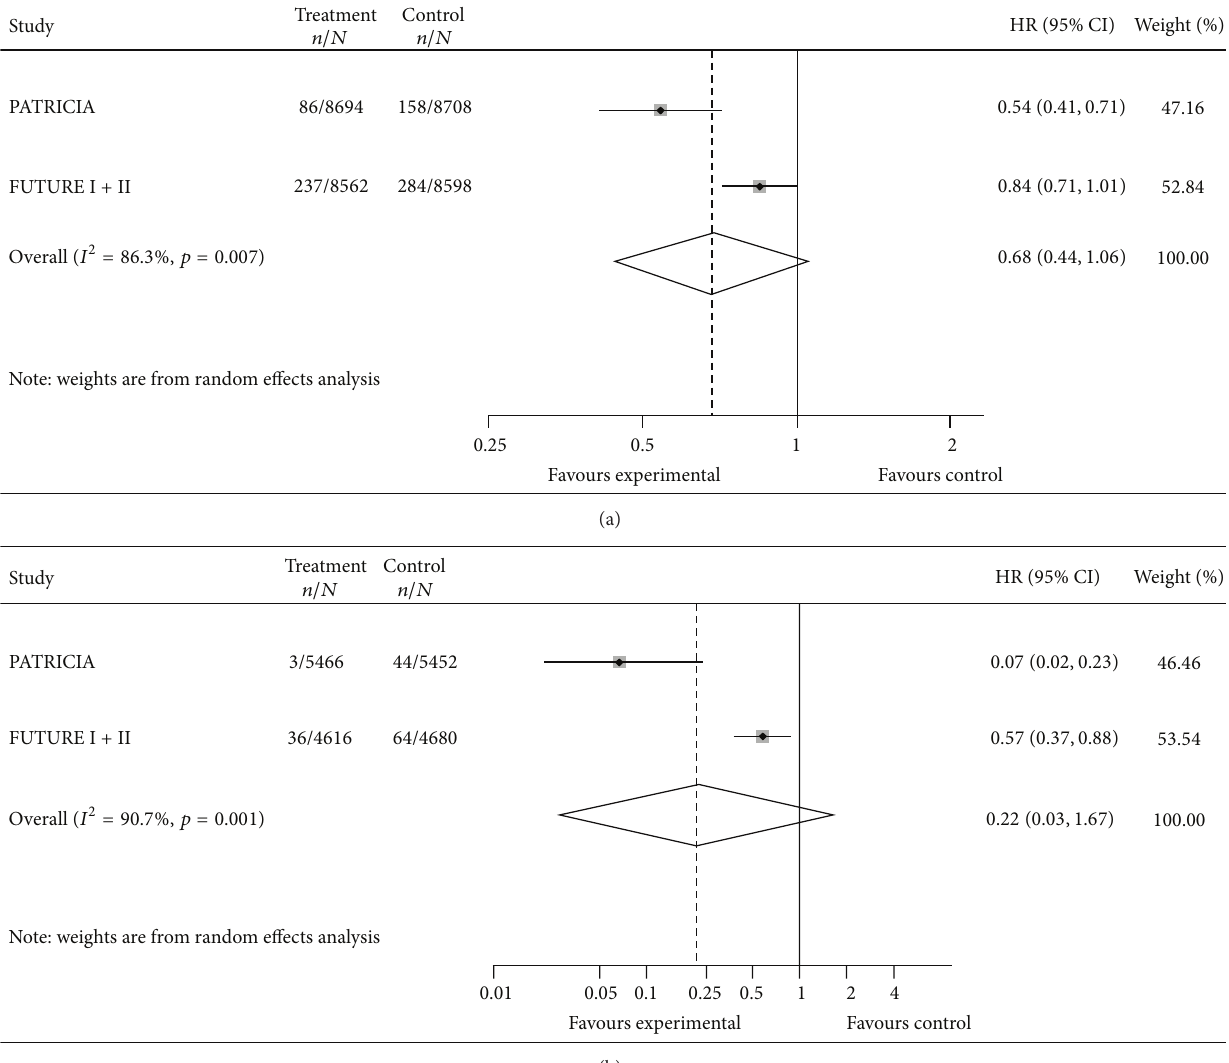
Figure 3: Vaccine efficacy against CIN3+ lesions, in total vaccine (a) and total vaccine na¨ıve cohort (b), any HPV